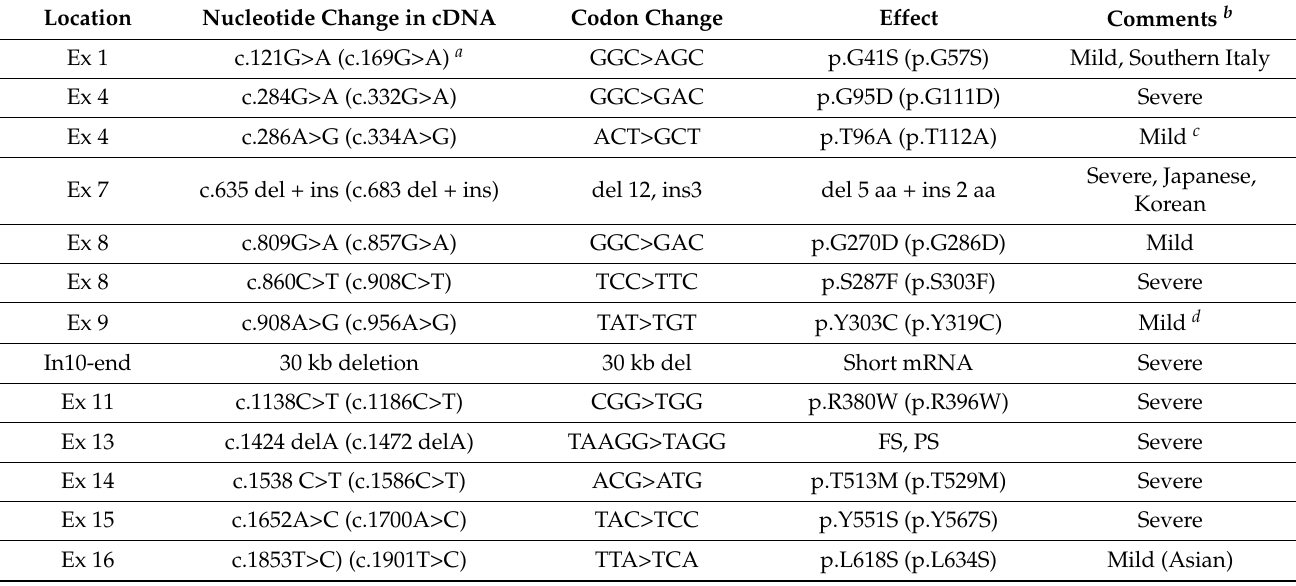
Table 1. Common Pathogenic Variants in the GALC Gene.